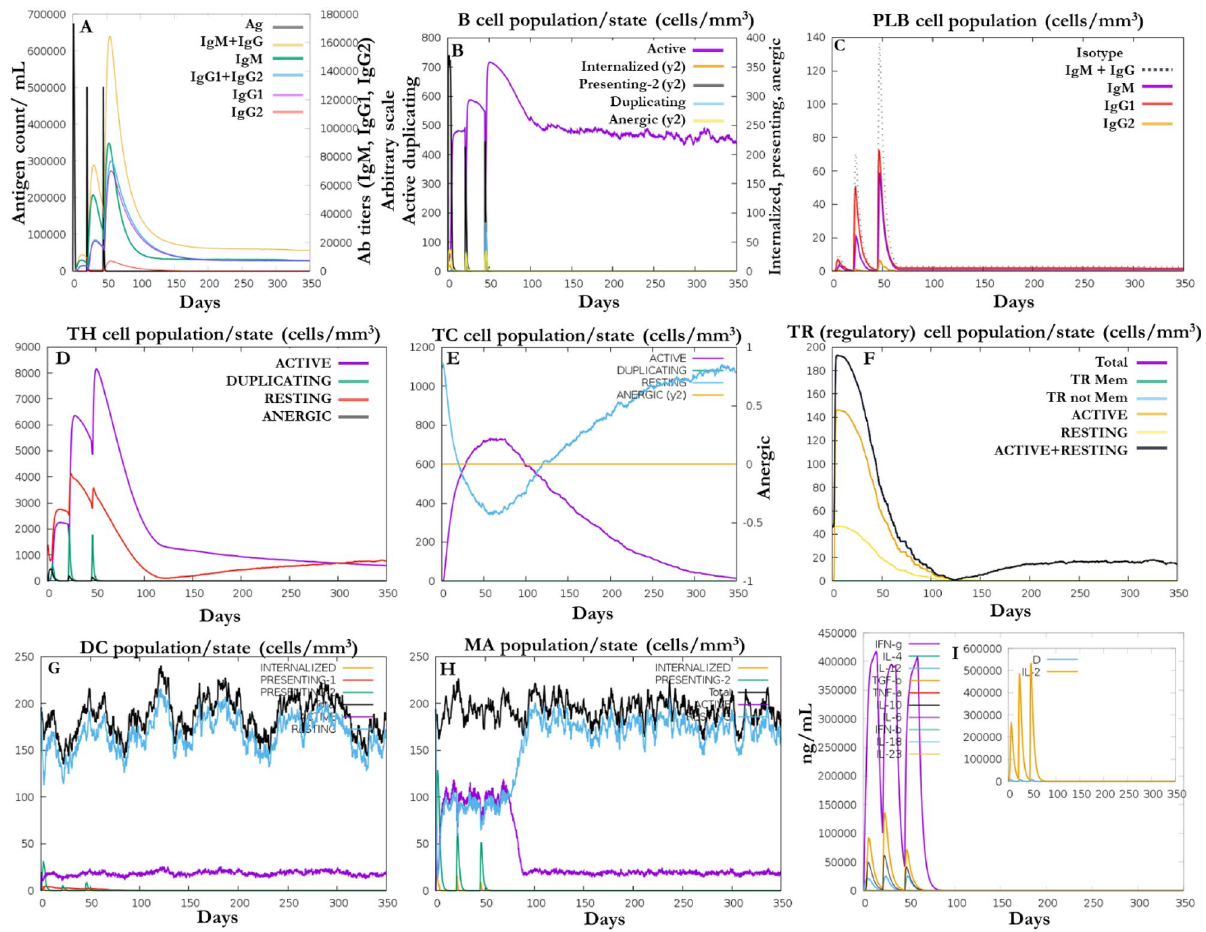
Figure 10. Immunogenic potential of the designed vaccine (DV-1). In response to the exposure of DV-1 after three injections, ( A ) production of immunoglobulins ( B ) active B-cell populations/state; ( C ) plasma B-lymphocytes and their isotypes per state; ( D ) helper T-cell population/state; ( E ) cytotoxic T-cell population/ state; ( F ) reduction in the level of T regulatory cells; ( G ) dendritic cell population per state; ( H ) activity of macrophage population/state; ( I ) cytokine level and interleukins (smaller plot) in different states with the Simpson index (dotted line). All units are in cells/mm 3 in three subsequent immune